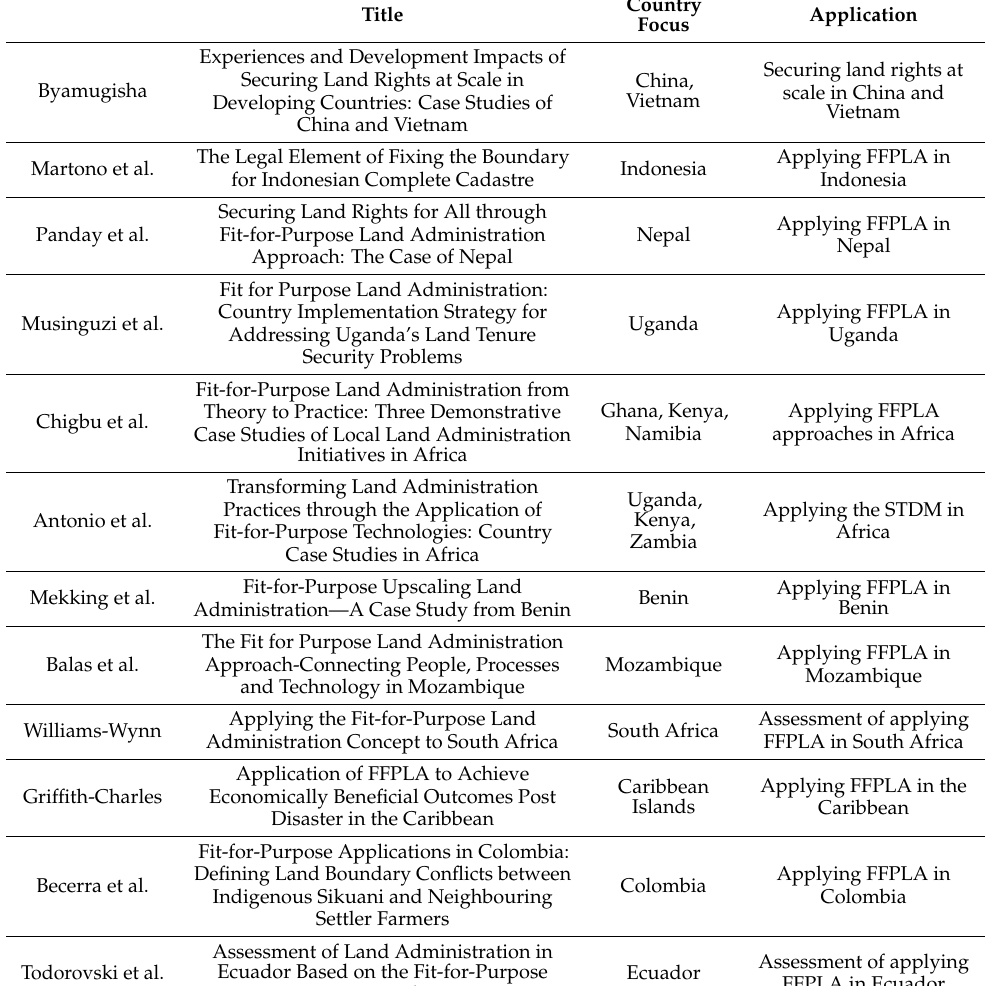
Table 2. Country